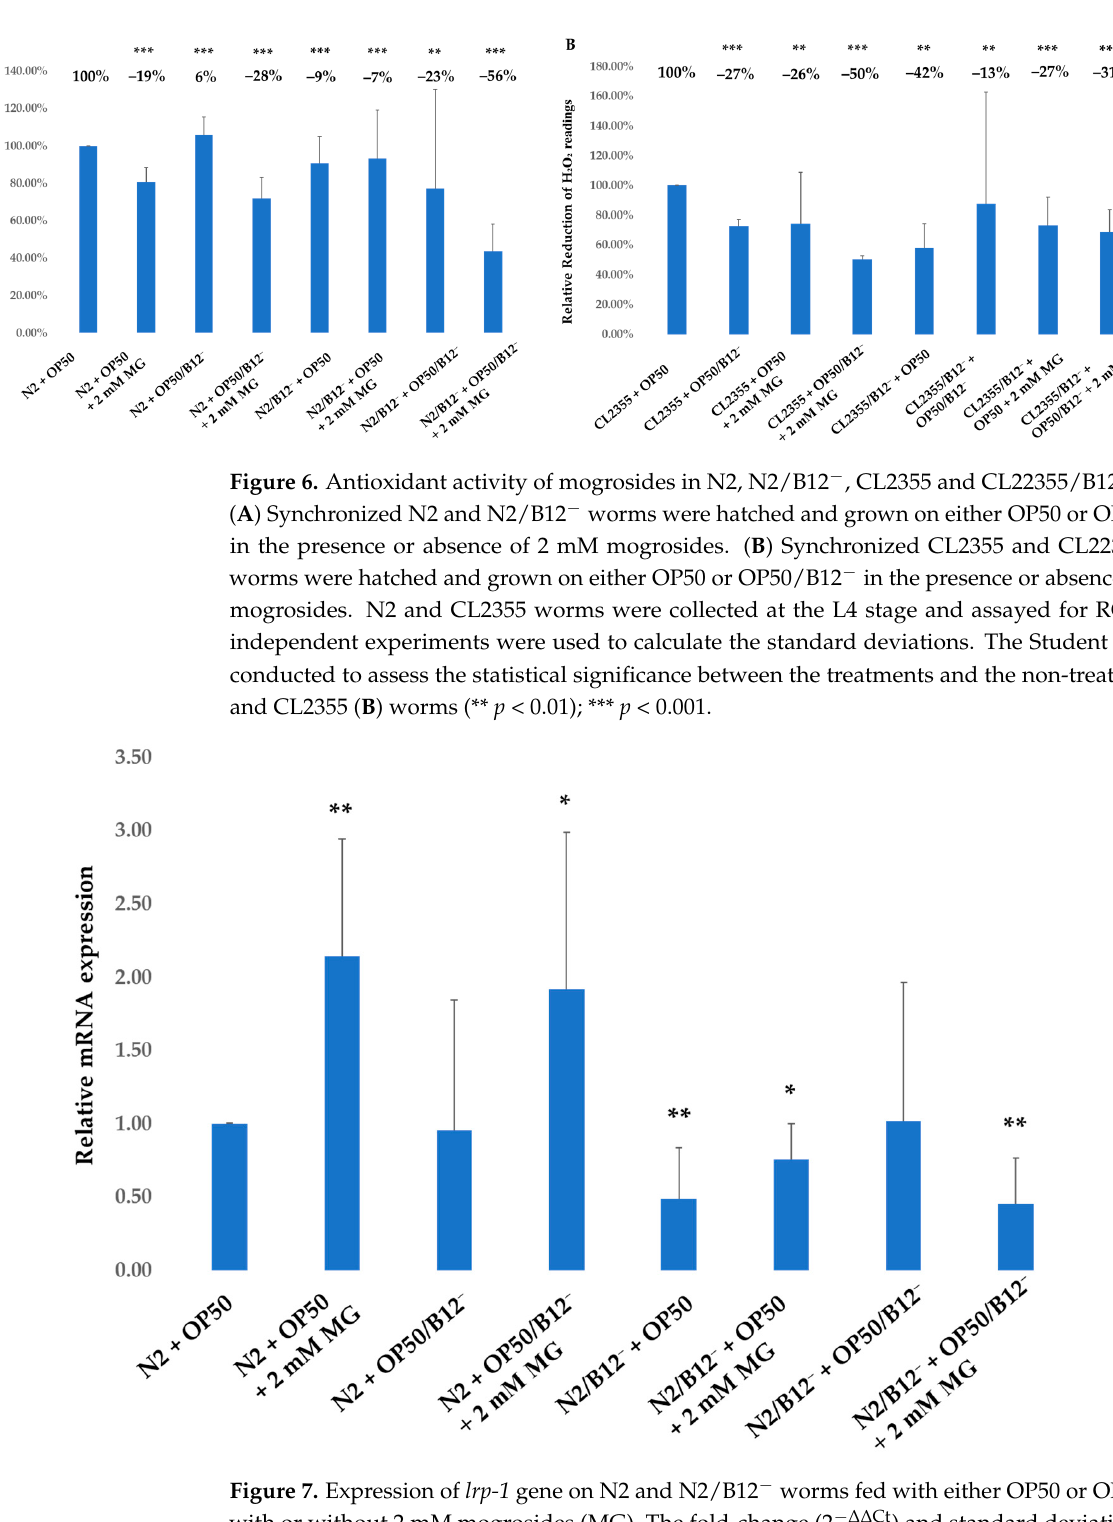
8 of 18 Figure 5. Expression of sod-1 ( A ), gpx-1 ( B ), ctl-1 ( C ) and gst-10 ( D ) genes in CL2355 and CL2355/B12 − worms fed with either OP50 or OP50/B12 − with or without 2 mM mogrosides (MG). The fold-change (2 −ΔΔ Ct ) and standard deviations of the gene expression were calculated from three independent experiments. All treatments were compared to N2 + OP50. The Student t -test was conducted to assess the statistical significance (* p < 0.05; ** p < 0.01; *** p < 0.001). 2.4.2. Antioxidant Activity of Mogrosides on N2, N2/B12 − , CL2355 and CL2355/B12 − C. elegans Oxidative stress has been widely associated with both A β toxicity and the pathology of AD [33]. DCF-DA dye was used to measure intracellular levels of H 2 O 2 -related ROS in N2, N2/B12 − , CL2355 and CL2355/B12 − worms treated with 2 mM mogrosides under regular and vitamin B12-deficient conditions. Our data show that 2 mM mogrosides reduced H 2 O 2 levels by 19% ( p = 5.626 × 10 − 6 ) in N2 + OP50 (Figure 6A). In N2 + OP50/B12 − , the H 2 O 2 level increased by 6% ( p = 3.545 × 10 − 5 ) and mogrosides reduced it by 28% ( p = 1.960 × 10 − 5 ), compared to N2 + OP50 (Figure 6A). In N2/B12 − + OP50, the H 2 O 2 level was slightly reduced (9%, p = 8.994 × 10 − 5 ), and the